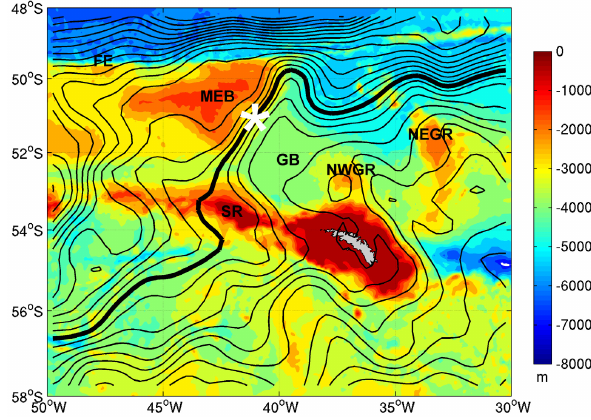
Fig. 2. Bathymetry (in colour) and climatological circulation (black lines) in the South Georgia region. Black lines correspond to Aviso dynamic topography isopleths for the summer climatol- ogy (December–February, from 1997–2010). Isopleths are equally spaced every 5dyncm, and dynamic topography values decrease from north to south; for reference, the − 71dyncm contour line used by Venables et al. (2012) to locate the southern extent of the Polar Front is shown in bold. FE: Falkland Escarpment, MEB: Maurice Ewing Bank, GB: Georgia Basin, SR: Shag Rocks, NWGR: North West Georgia Rise and NEGR: North East Georgia Rise. The po- sition of the MEB–GB margin, referred to in the text, is indicated with a white